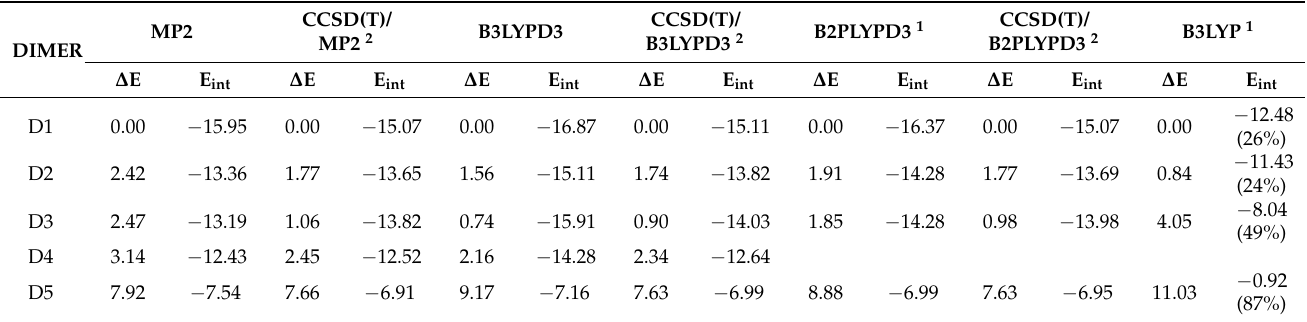
Table 2. BSSE-corrected interaction energies E int and relative energies ∆ E (kJ mol − 1 ) of the HNCO dimers calculated at MP2, B3LYP, B3LYPD3, B2PLYPD3 and CCSD(T) levels with 6-311++G(3df,3pd) basis